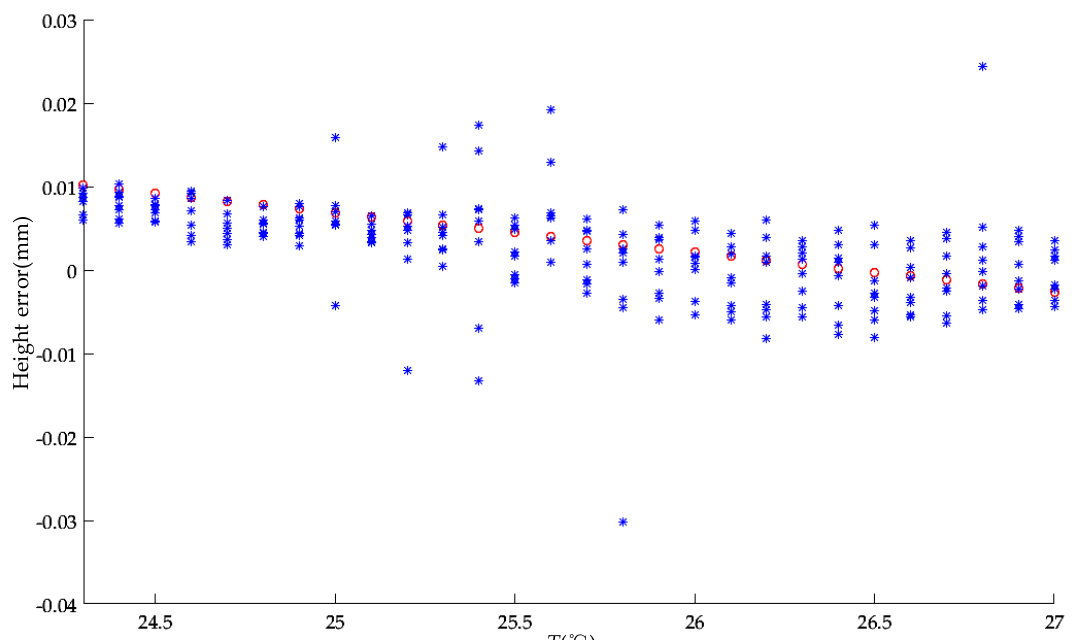
Figure 9. Support height error when injecting hydraulic oil with filtered air.